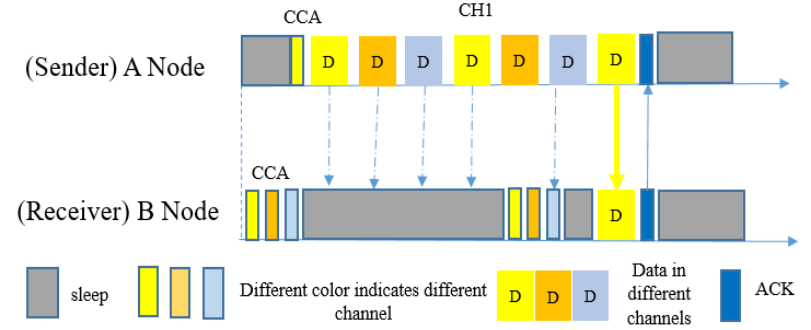
Figure 16. Sender- and receiver-initiated fast channel hopping scheme in MOR [14].